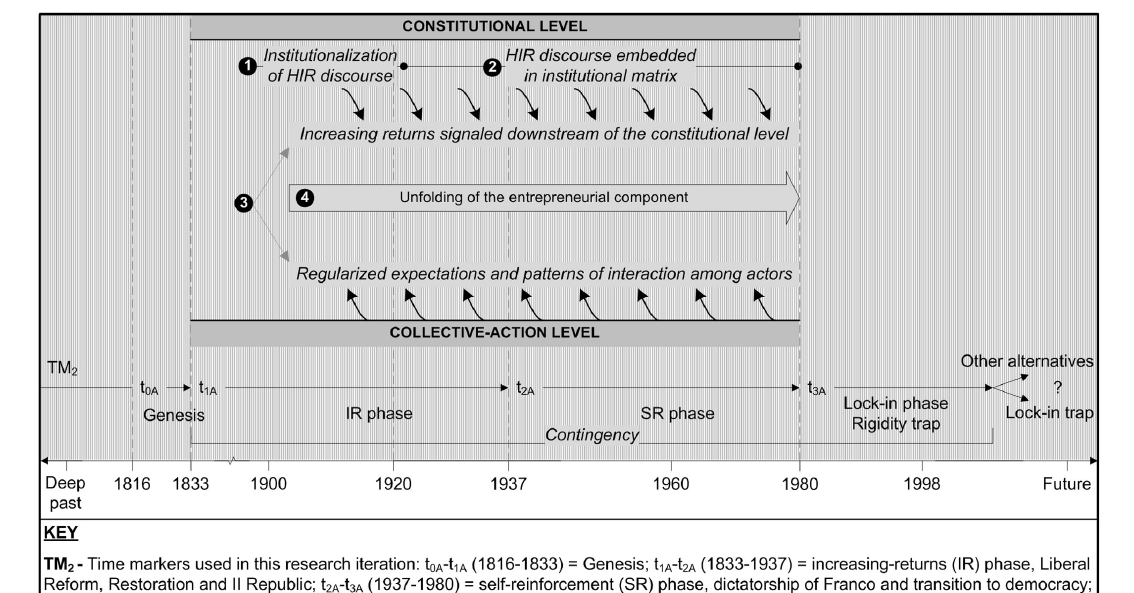
Fig. 6 . Graphical depiction of the mechanisms that contributed to the emergence of the Doñana’s systemic rigid outcome. HIR = hydraulic-irrigation